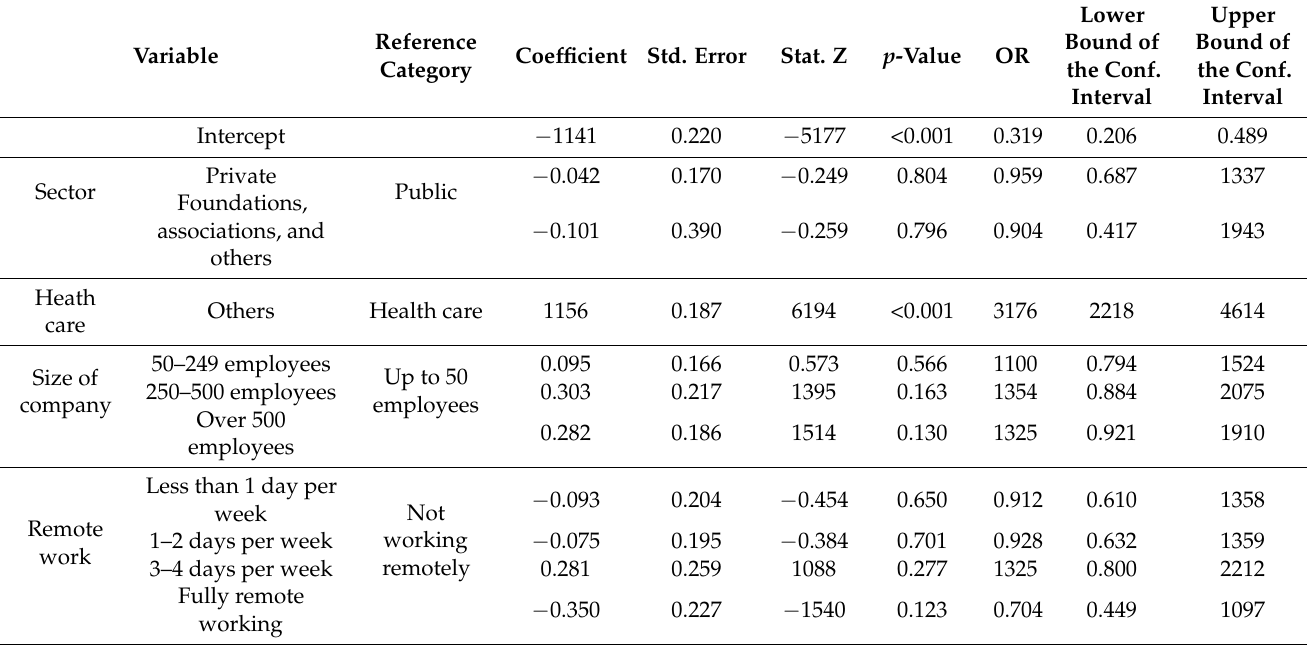
Table 5. A logistic model explaining the chance of well-being—“physical and mental health” factor.